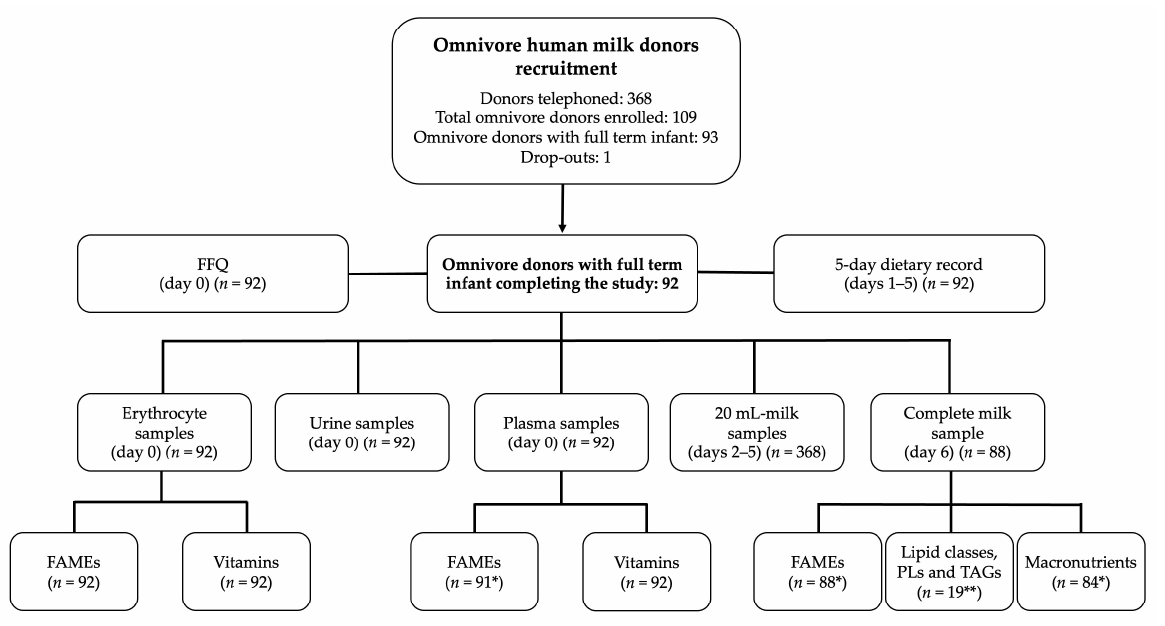
Figure 2. Flow chart for omnivore human milk donors’ recruitment and sampling. * The difference between 92 and the number of samples reflects missing data. ** Corresponding to a randomly selected subgroup of 19 omnivore donors with full-term infants. Abbreviations: FFQ, food frequency questionnaire; FAMEs, fatty acid methyl esters; PLs, relative composition of phospholipids; TAGs, molecular species of triacylglycerols.